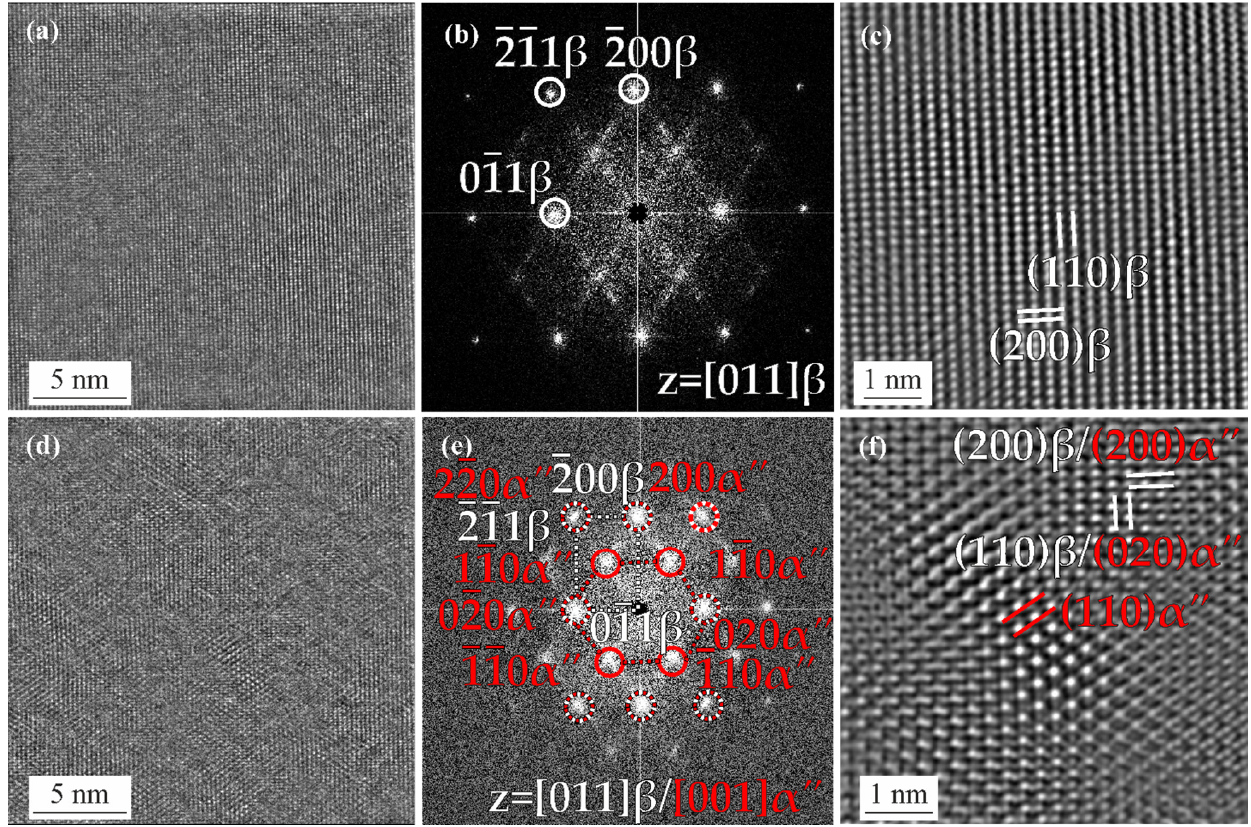
Figure 5. HRTEM, FFT, and Fourier filtered HRTEM images from the black, dashed square region in Figure 4b; ( a ) HRTEM and ( b ) FFT images of the β phase in ( a ), zone axis is [011] β ; ( c ) higher magnification Fourier filtered HRTEM image of the β matrix in ( a ); ( d ) HRTEM and ( e ) FFT images of the α″ and β phase in Figure 4b, zone axis in is [011] β /[001] α″ ; ( f ) higher magnification Fourier filtered HRTEM image of the α″ and β phase in ( d ).